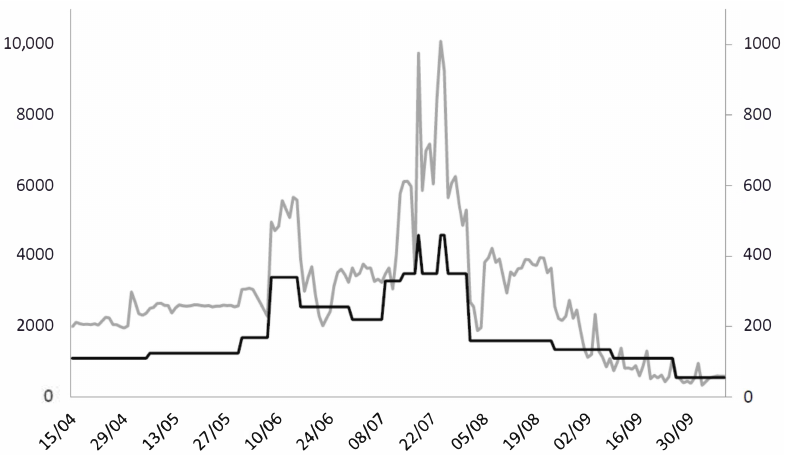
Figure 3. Number of daily doses and staff in the Toulouse Mass Vaccination Center. Vertical left axis and grey line: number of daily doses; vertical right axis and black line: number of staff